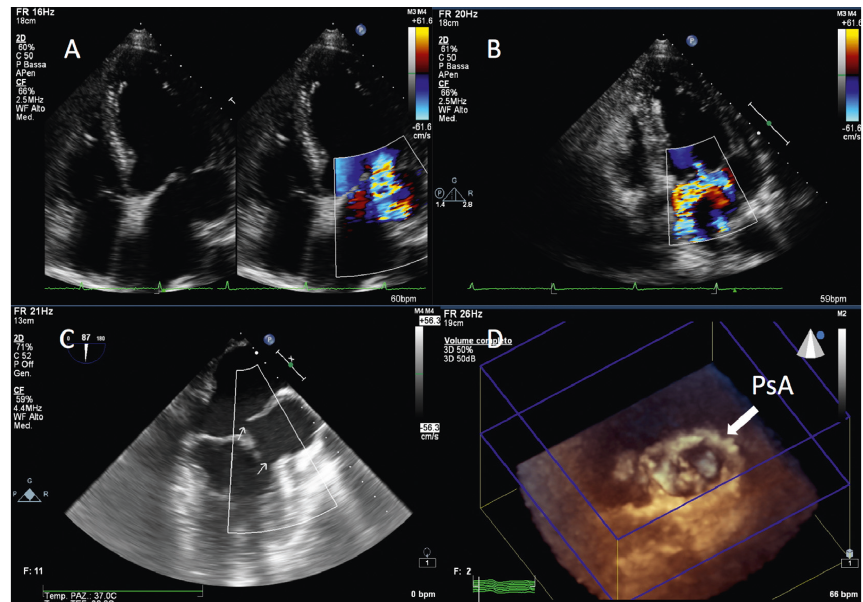
Figure 1: Transthoracic echocardiography showing the submitral pseudoaneurysm (A); at color Doppler, communication between the false chamber and left atrium is evident (B); transesophageal echocardiography displayed the false chamber communicating with both the left atrium and left ventricle (C, arrows); 3D transthoracic echocardiography displaying the left atrium and the false chamber (PsA) paired